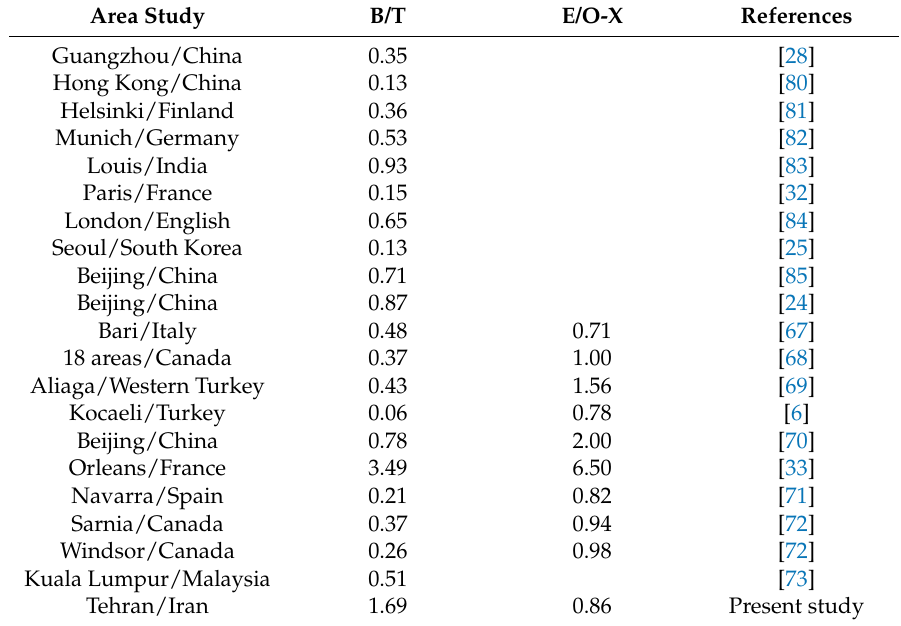
Table 4. Comparison of benzene/toluene (B/T) and ethylbenzene/o-xylene (E/o-X) concentration ratio in Tehran and other